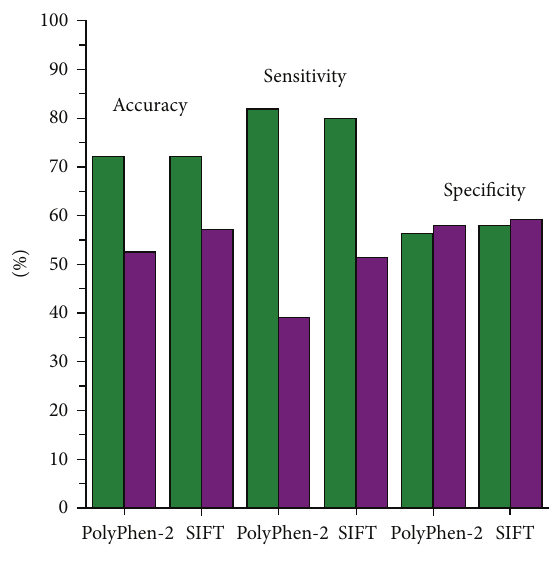
Figure 2: Performance of PolyPhen-2 and SIFT on the entire dataset (CFDs and nCFDs) and on the subset of variations outside CFDs